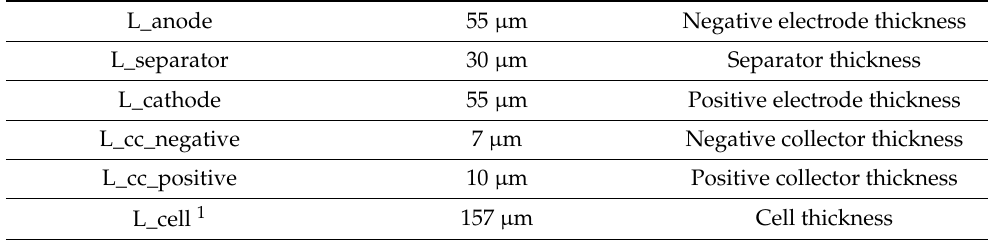
Table 1. Cell’s component